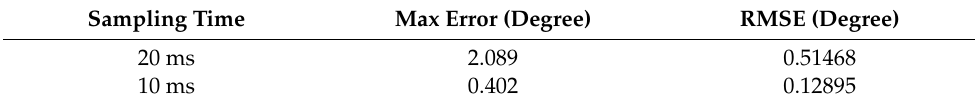
Table 6. Comparison table of tracking outcomes at different sampling